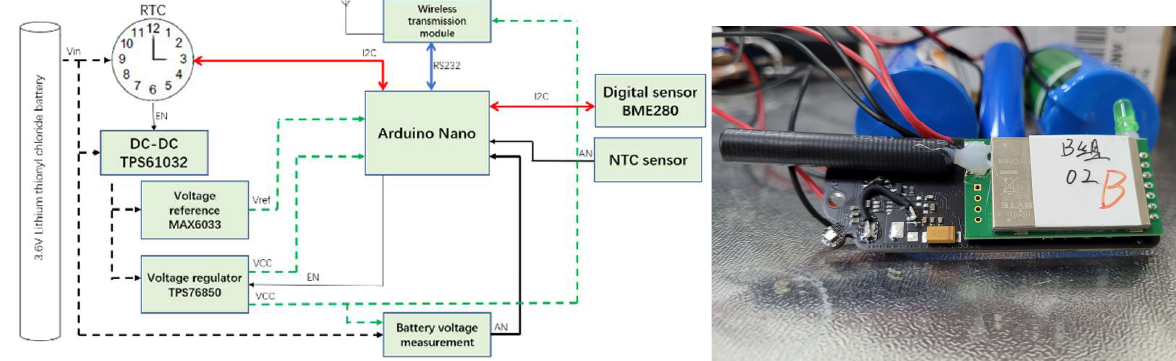
Figure 2. Structure diagram ( left ) and an example of the real sensors ( right ) for the glacier internal measurement unit.